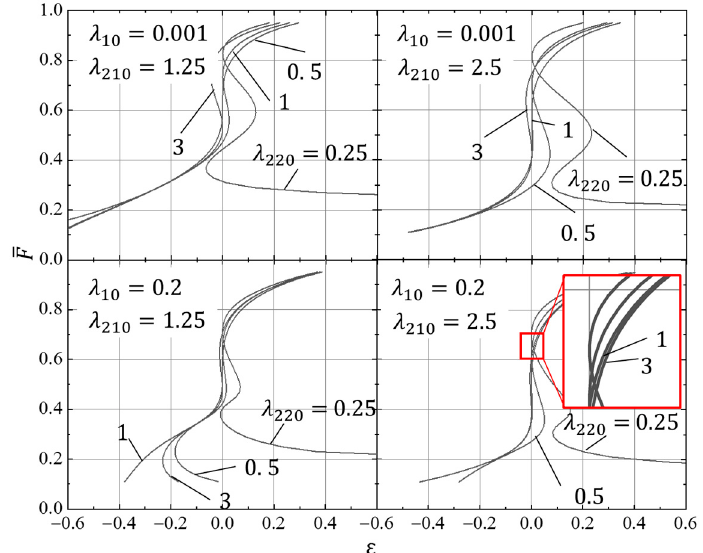
Figure 6. The effect of λ 220 on the static characteristics of the oil pad. Referring to the previous conclusion, the effect of F on ε is calculated for the single oil pad with a different flow resistance ratio λ 10 for four combinations of parameters λ 210 , λ 220 . As shown in Figure 7, when λ 210 and λ 220 are properly designed, λ 10 does not negatively affect the performance of the hydrostatic bearing in the range from 0 to 0.4.